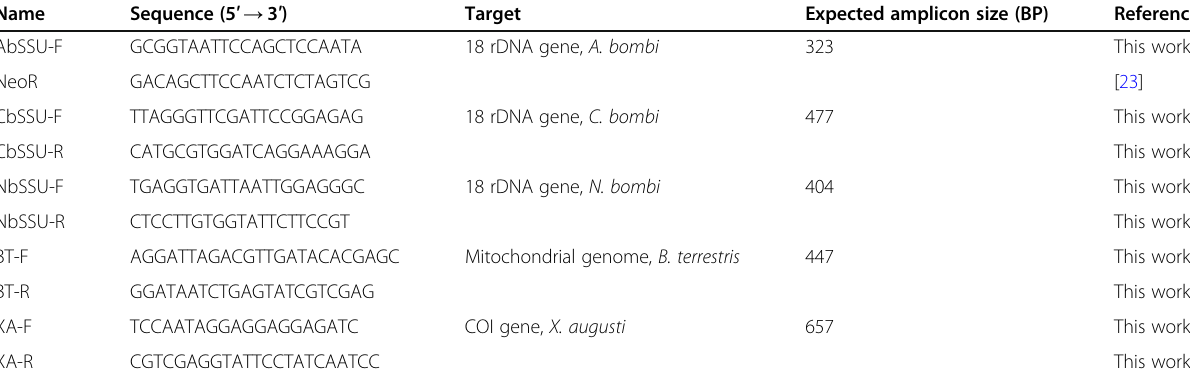
Table 2 List of primers used in PCR. See Methods section for